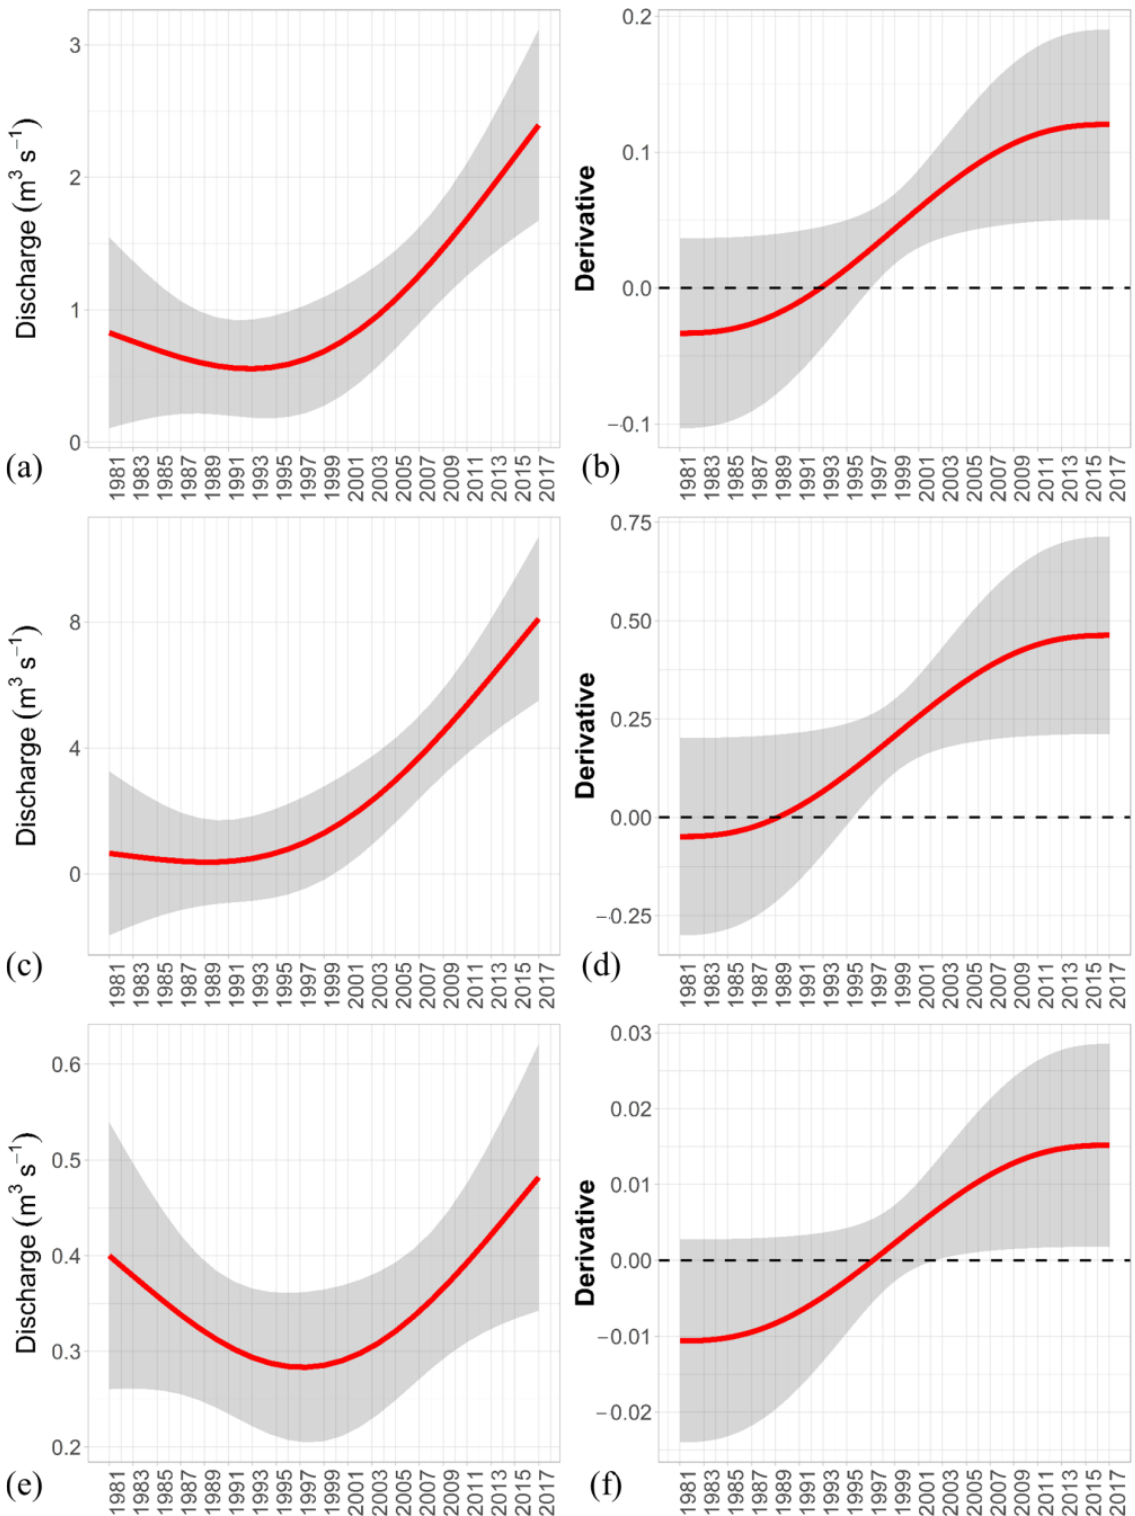
Figure 4. Generalized additive modeled fits of September’s discharge for sub-basins ( a ) PINUP, ( c ) TITAR, and ( e ) MREMA. Subplots ( b , d , f ) show the rate of change for sub-basins PINUP, TITAR, and MREMA, respectively. The shaded area represents the 95% confidence interval.